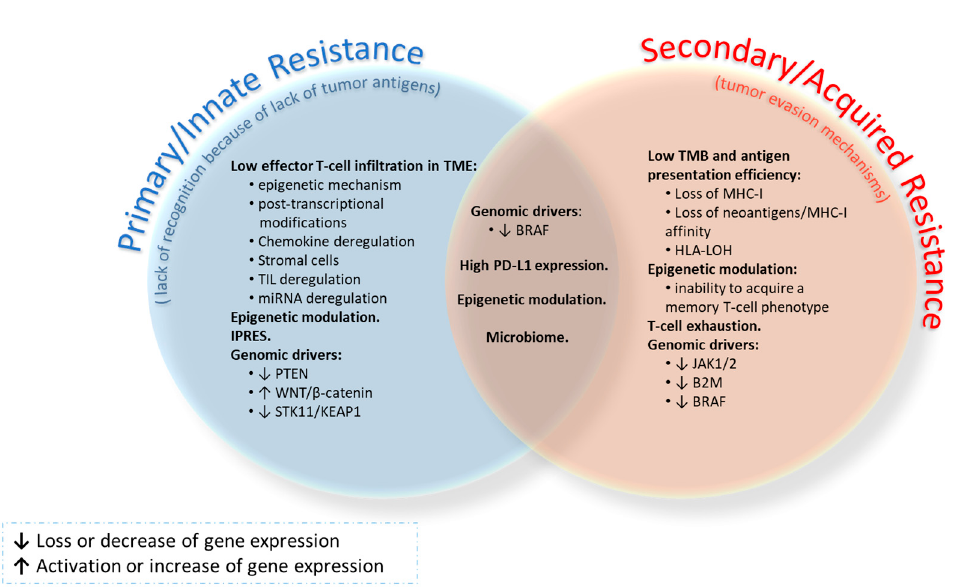
Figure 2. Classification of the most relevant resistance mechanisms to ICI therapies operating in lung